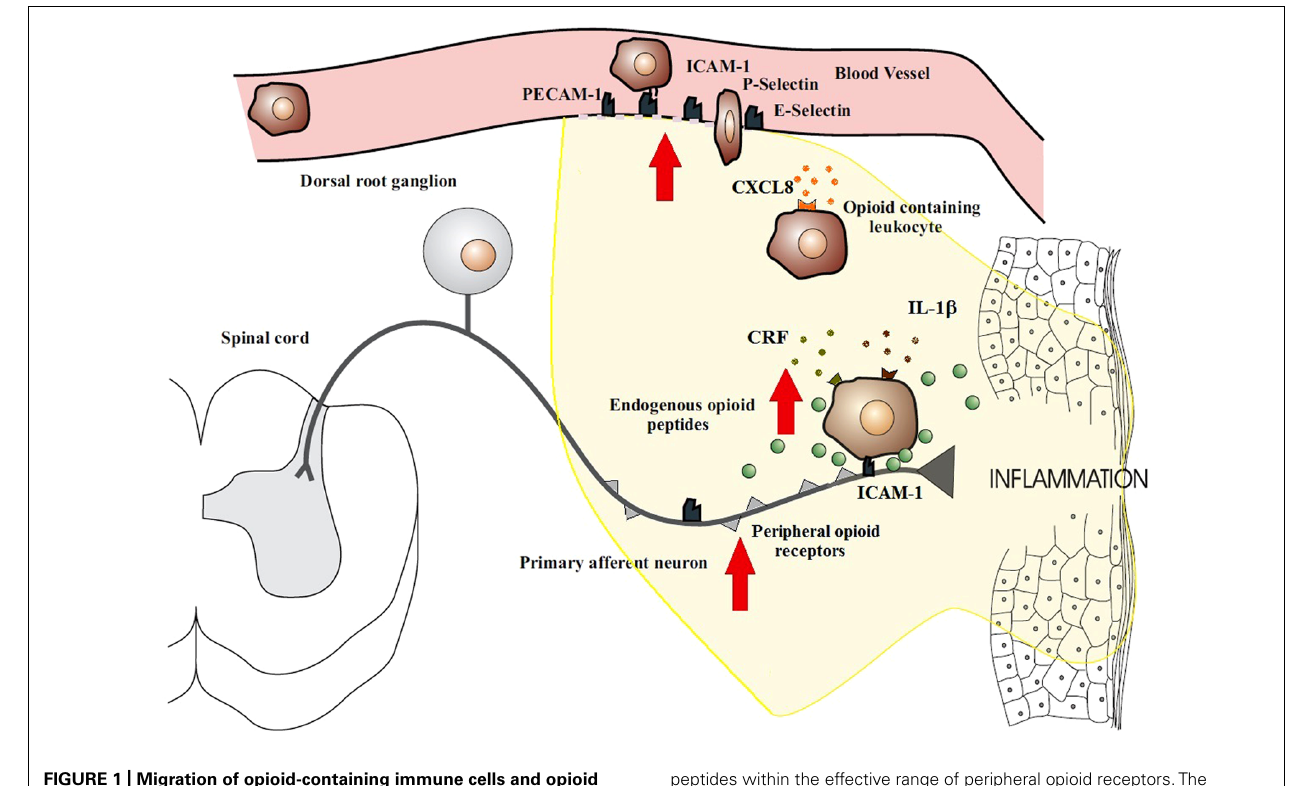
FIGURE 1 | Migration of opioid-containing immune cells and opioid release within inflamed tissue . Adhesion molecules interact with their respective ligands to facilitate endothelial transmigration of immune cells. In response to stress or releasing agents (e.g., CRF, IL-1, CXCL8), the immune cells secrete opioid peptides. Opioid peptides or exogenous opioids bind to opioid receptors on primary afferent neurons, leading to analgesia. Direct adhesion between opioid-containing immune cells and peripheral sensory neurons (via ICAM-1 and/or NCAM) may be necessary to release opioid